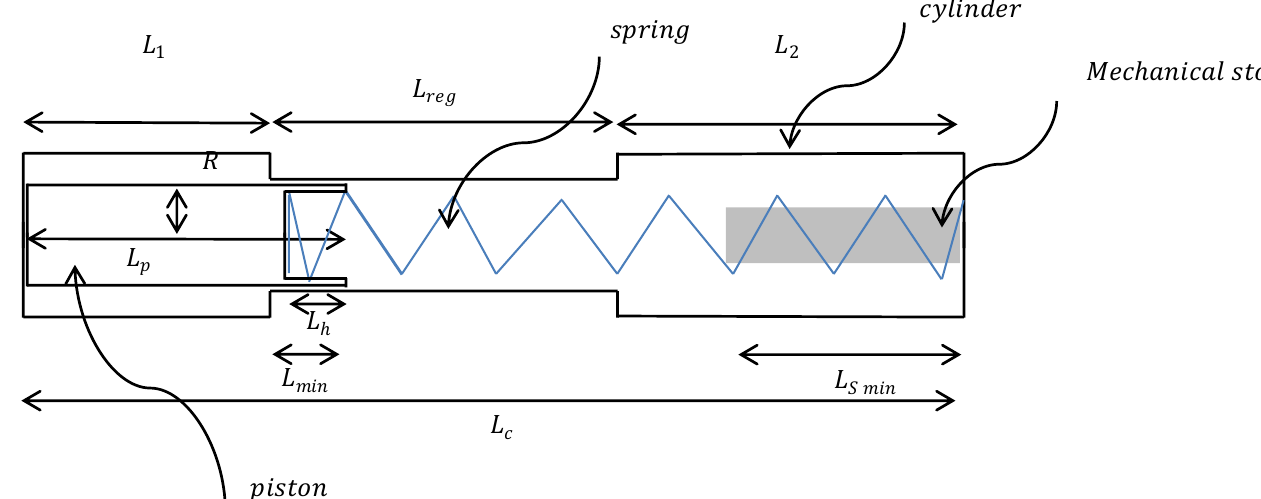
Figure 2. Schematic cross-section of the adjustable flow-control valve. The notations are described in the nomenclature.